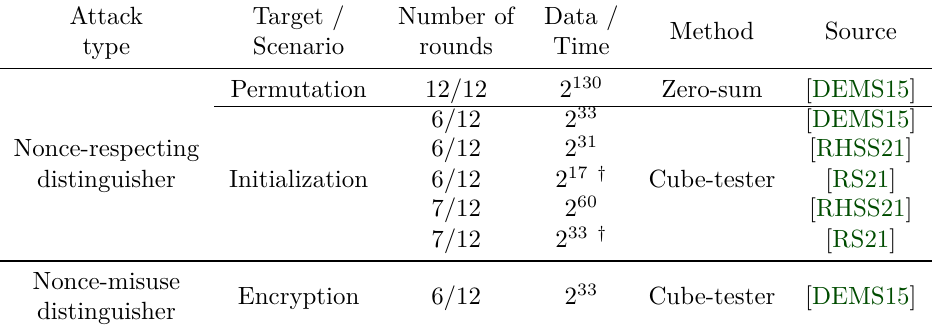
Table 7: Summary of the cube-like distinguishers against Ascon